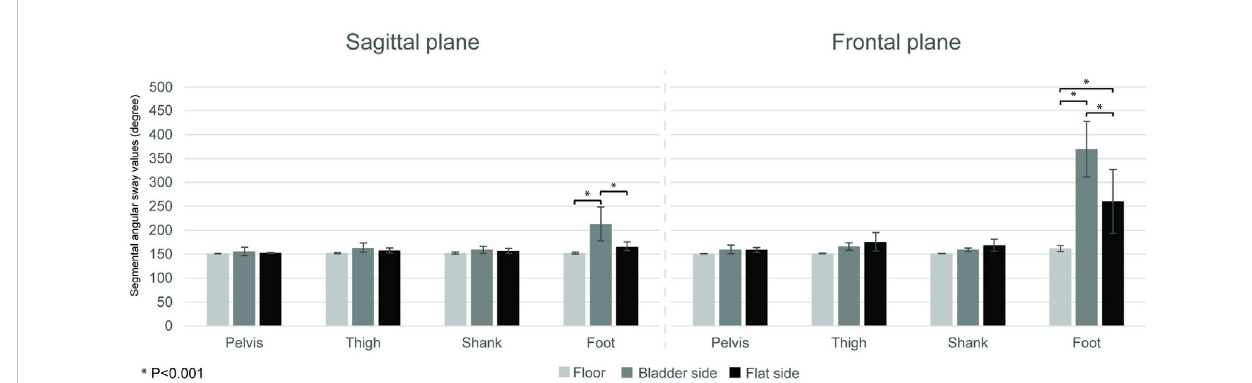
FIGURE 4 Segmental angular sway over the 10 s stand trials. Bars show the segmental angular sway values (mean ± SD) in the three conditions ( fl oor, and bladder and fl at side of the Togu Jumper) for the leg segments (pelvis, thigh, shank, foot) in frontal and sagittal plane. Horizontal bars represented signi fi cant differences ( p <